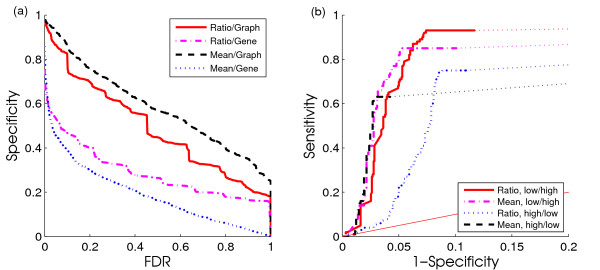
False positive rates and ROC curves of CSA for different parameter settings. (a) False positive rate of CSA with different parameter settings at different FDR levels. (b) ROC curves of mean function and ratio function of low/high and high/low simulated data. (a) The plot clearly shows that the estimated FDR can well control false positive rate of CSA. Both scoring functions with graph permutation reach low false positive rate when applying a reasonable FDR cutoff (FDR < 0.05). (b) The ROC curves suggests that the ratio scoring function reaches better true positive rate at the expense of a similar gain in false positive rate on datasets that contain few highly correlated regulatees.